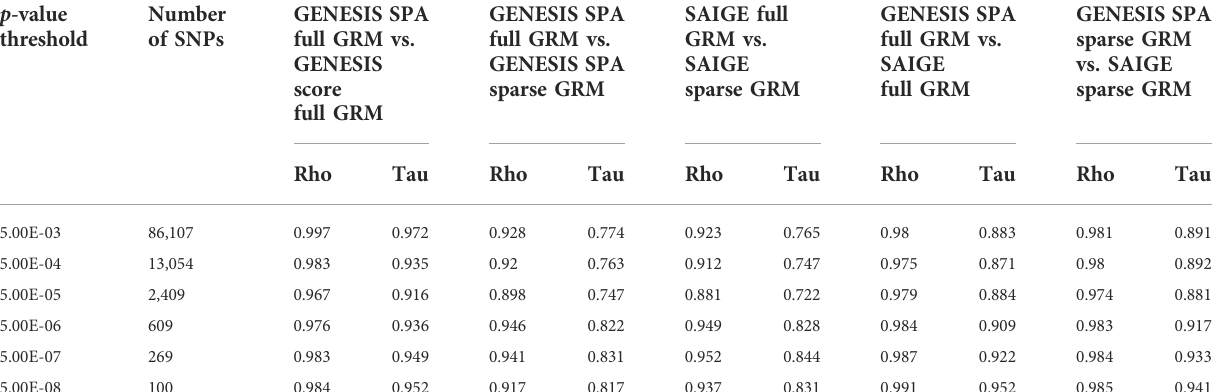
TABLE 2 Correlations of the ranks of the p -values for NECS imputed genotype data. p -value